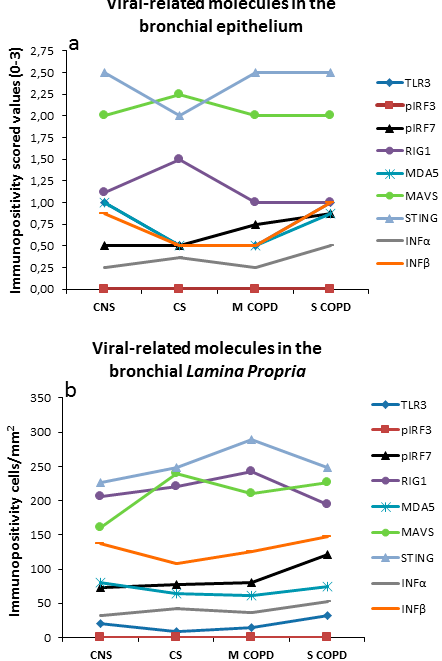
Figure 1. Schematic representation of the molecular variations related to anti-viral innate immunity response in the ( a ) bronchial epithelium and in the ( b ) bronchial lamina propria of control non-smokers, control smokers, mild/moderate stable COPD and severe/very severe stable COPD patients. Molecules involved in the anti-viral immune response are either poorly expressed (IFN α , IFN β ) or, when well expressed (RIG1, MDA5, MAVS, STING), values do not differ in the four groups of subjects studied. Range values for the molecules included in this graph are reported in Table 3. CNS = Control non-smokers; CS = Control smokers; MCOPD = Mild/moderate COPD; SCOPD = Severe/very severe COPD.